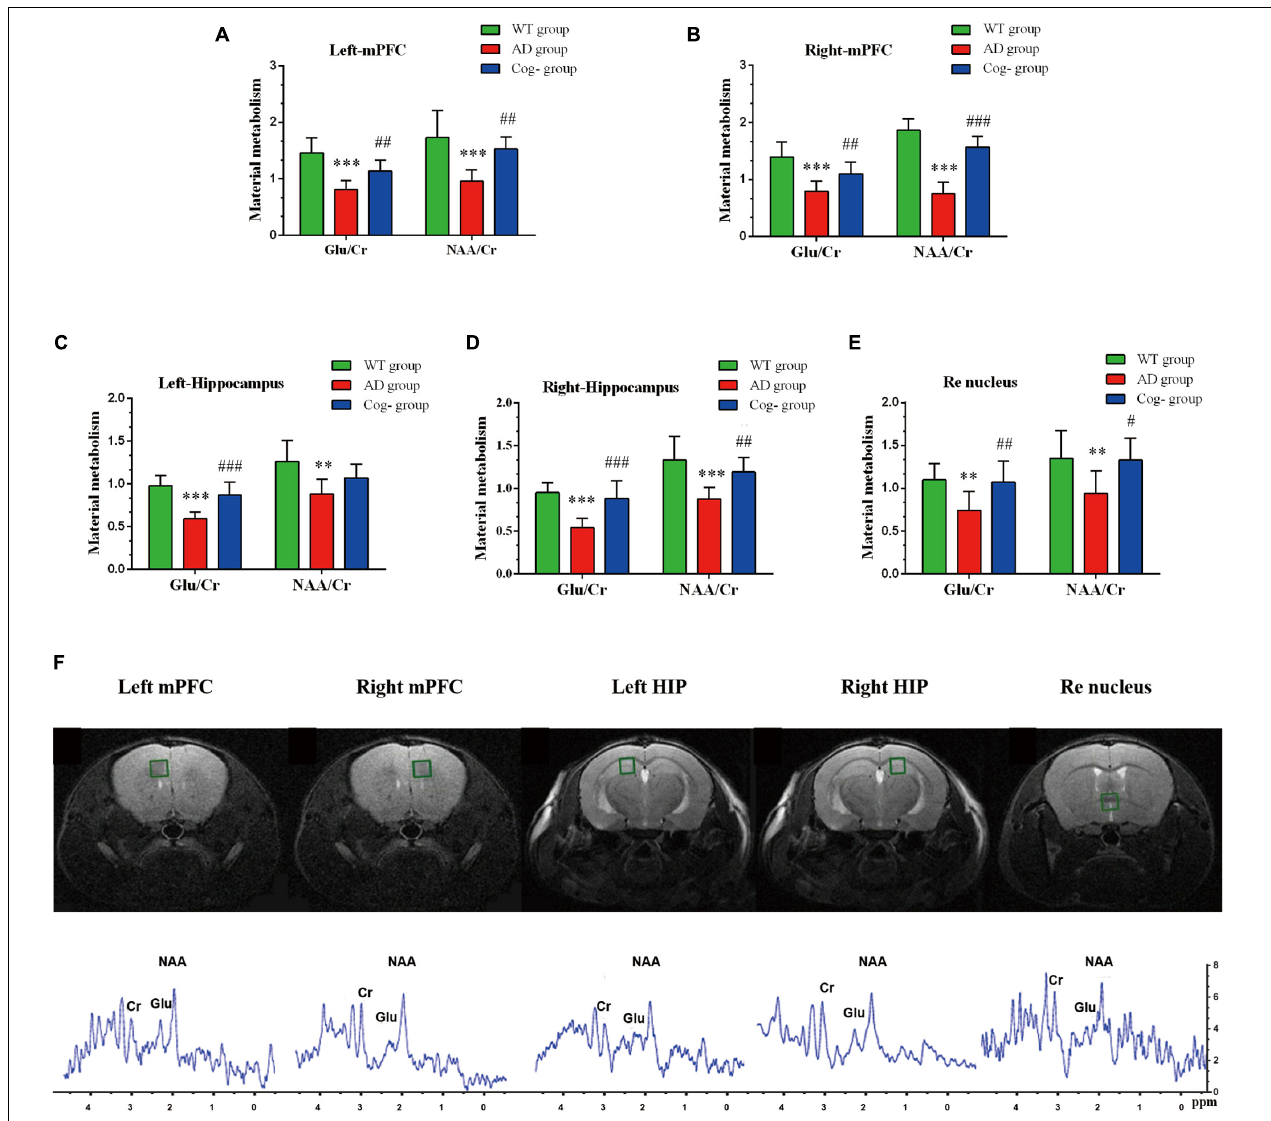
FIGURE 6 | Changes in neurochemical metabolism after cognitive training in APP/PS1 mice. (A–E) The neurochemical metabolism of Glu and NAA of each group in mPFC (left), mPFC (right), hippocampus (left), hippocampus (right), and Re nucleus. (F) The location and the representative graph in mPFC (left), mPFC (right), hippocampus (left), hippocampus (right), and Re nucleus. ∗ P < 0.05 compared with the WT group, ∗∗ P < 0.01 compared with the WT group, ∗∗∗ P < 0.001 compared with the WT group, # P < 0.05 compared with the AD group, ## P < 0.01 compared with the AD group, ### P < 0.001 compared with the AD